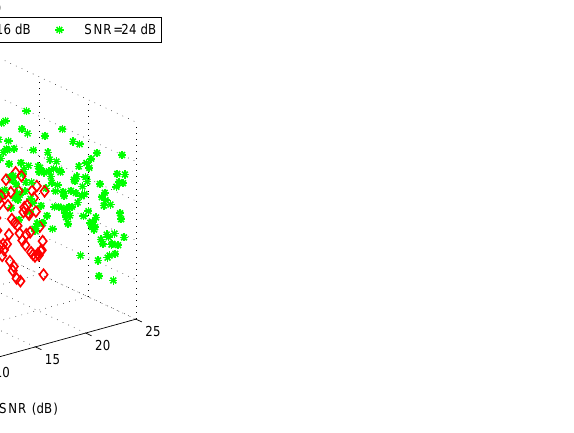
Figure 16. Behavior of the distributions of estimated NMSE using the existing method (CIM-LLAD) in system II.